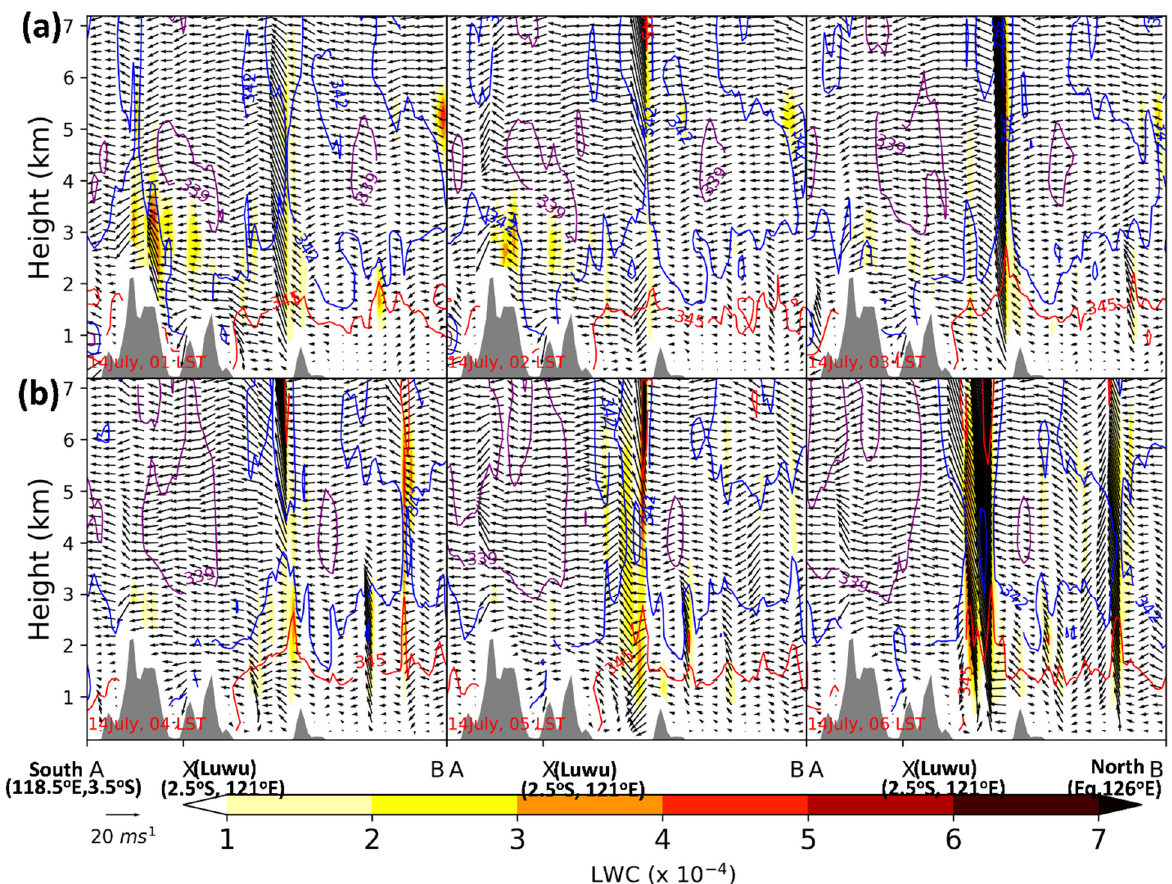
Figure 9. Same as Figure 8, but for ( a ) 01:00–03:00 LST and ( b ) 04:00–06:00 LST 14 July 2020.